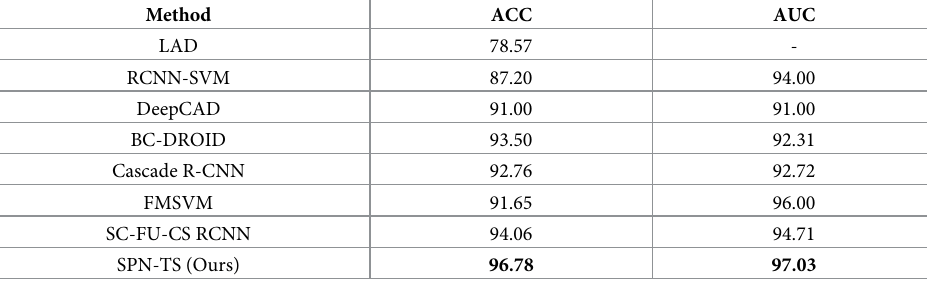
Table 2. Comparison of the method performance with existing medical